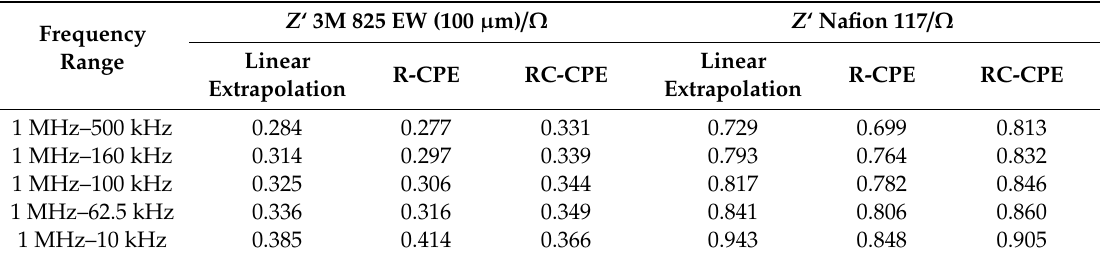
Table 2. Comparison of extrapolated and fitted resistance values for Nafion 117 and 3M